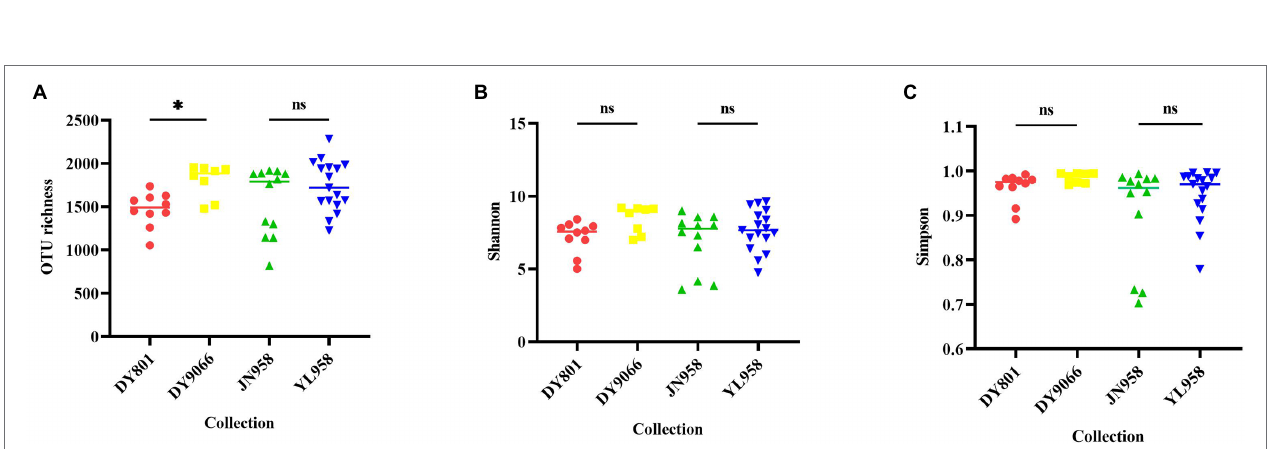
FIGURE 7 | Beeswarm Figures of species richness (OTU number) (A) , and community diversity measured by Shannon index (B) and Simpson (C) . Asterisk above each line represented difference at the significance level of 0.05 (Wilcox rank-sum test) between two populations. ns indicated that there was no significant